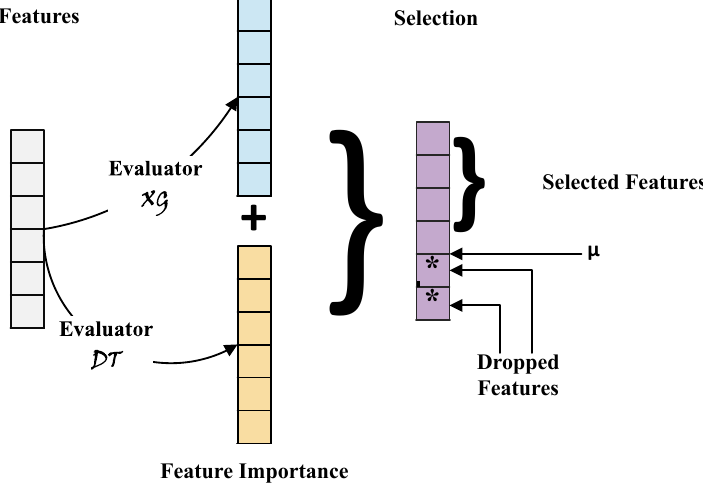
Figure 8. Hybrid feature